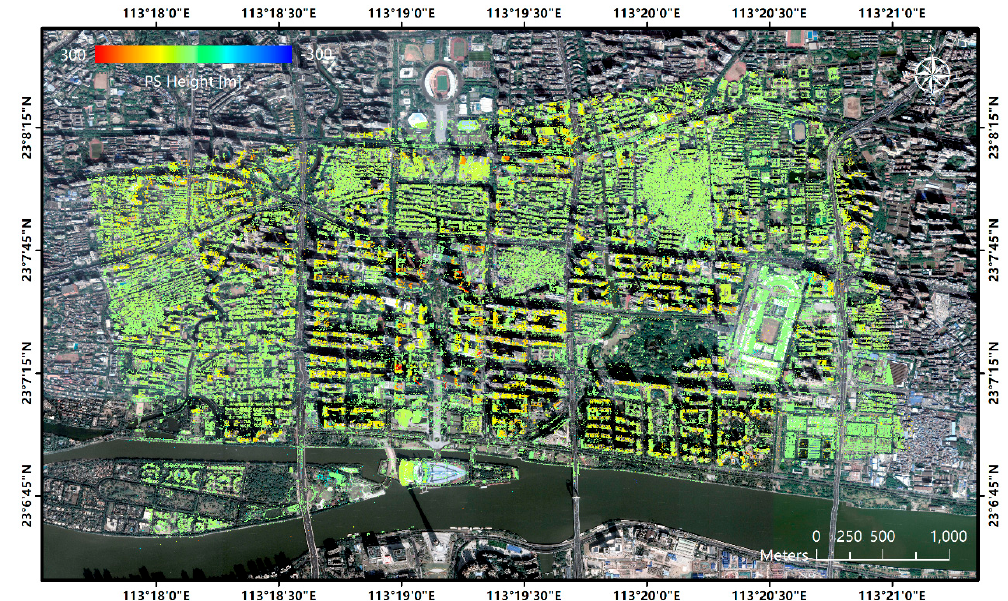
Figure 11. Residual height map for pursuit mono-static data in Guangzhou, using a proposed processing chain.